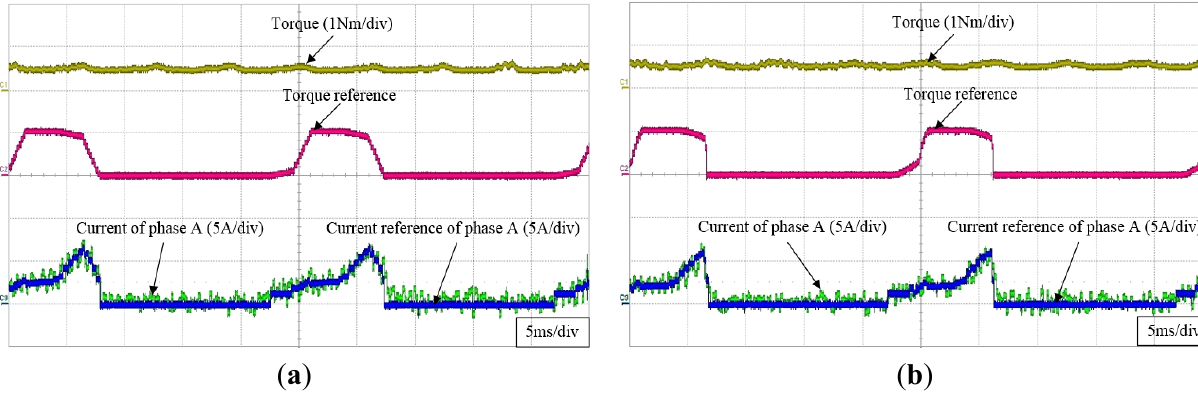
Figure 16. Experiment results at 600 rpm: ( a ) asymmetric TSF; ( b ) non-unity